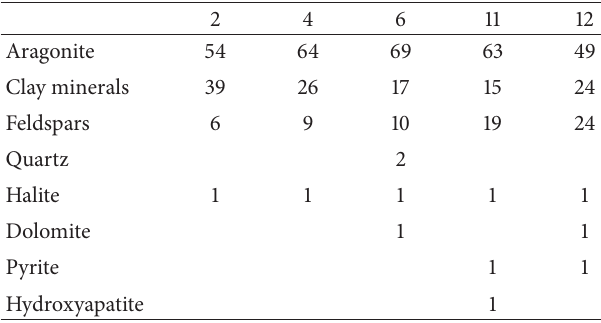
Table 1: Mean values (%) of semiquantitative mineralogic analysis of core sediments from lake Specchio di